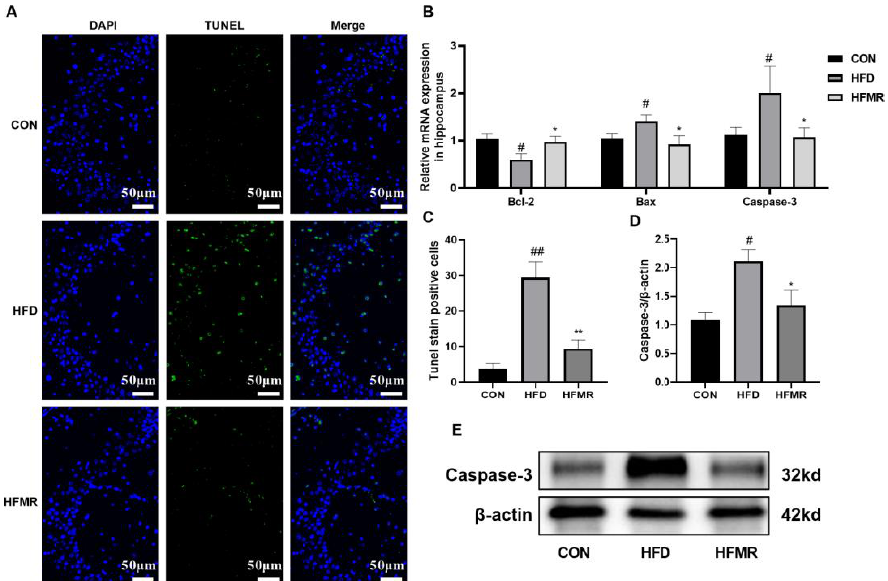
Figure 4. Effects of MR on neuronal apoptosis in the hippocampus of HFD-induced insulin-resistant mice. ( A ) TUNEL fluorescent assay of the hippocampus (200×). ( B ) mRNA expression of apoptosis- related genes. ( C ) The number of TUNEL-positive cells. ( D ) Relative protein expression of caspase-3 in hippocampus. ( E ) Caspase-3 western blotting bands. All data are shown as the mean ± SEM (n = 8). # p < 0.05, ## p < 0.01 (HFD versus CON); * p < 0.05, ** p < 0.01 (HFMR versus HFD).